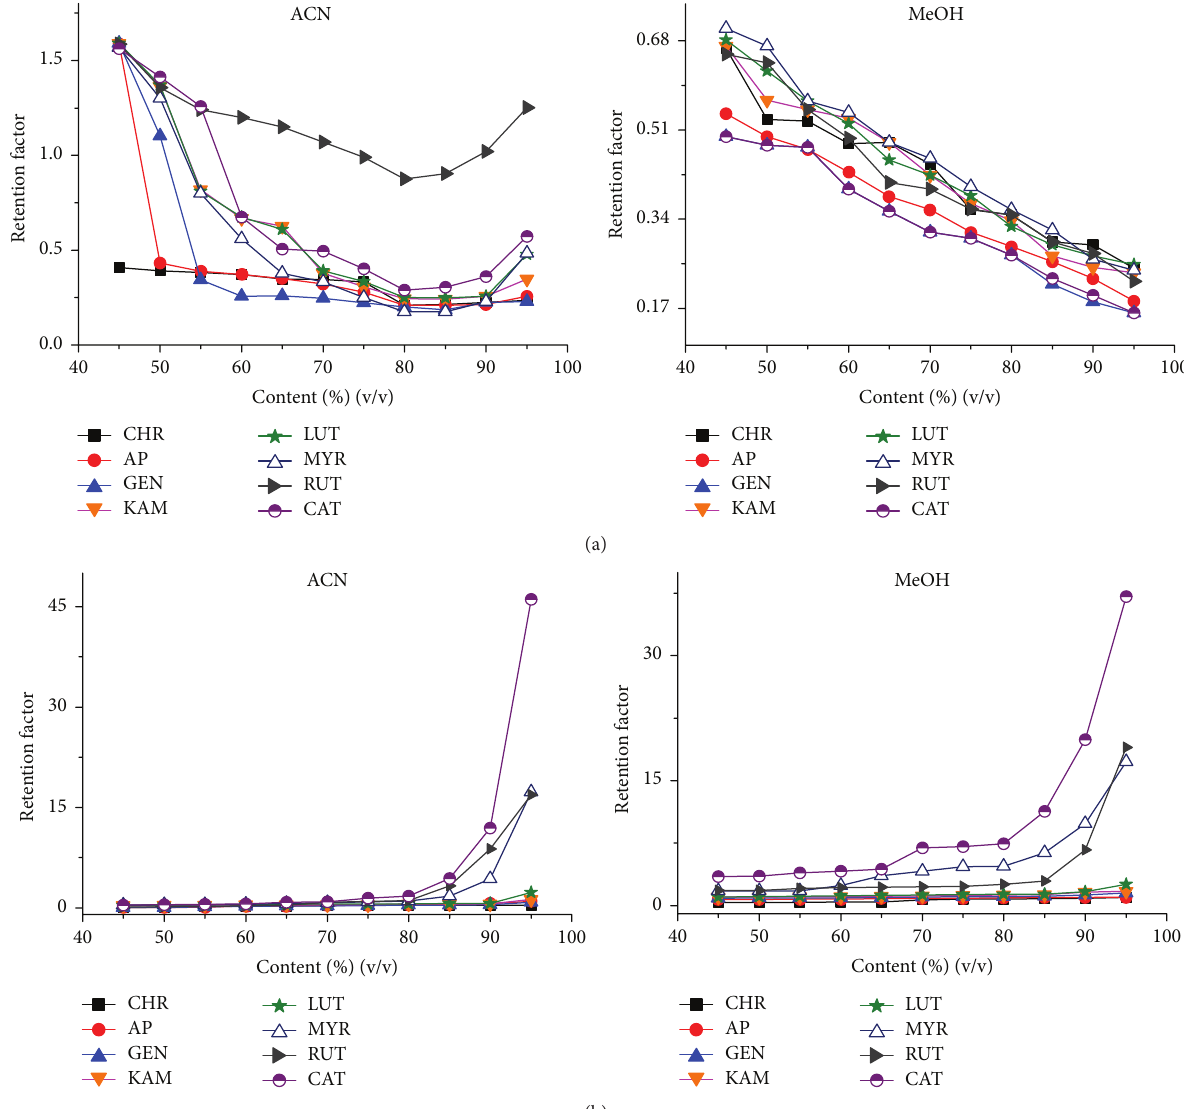
Figure 1: The retention factor as a function of ACN or MeOH content in the mobile phase. (a) Bare silica column; (b) ZIC column.